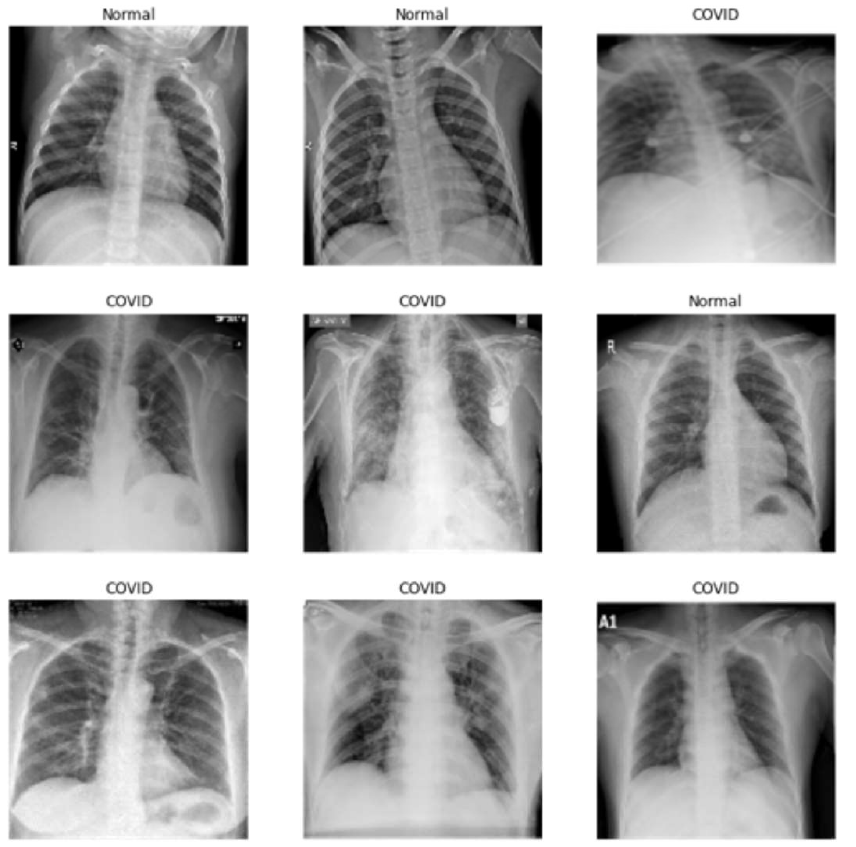
Figure 2. Original Chest X-ray Images.